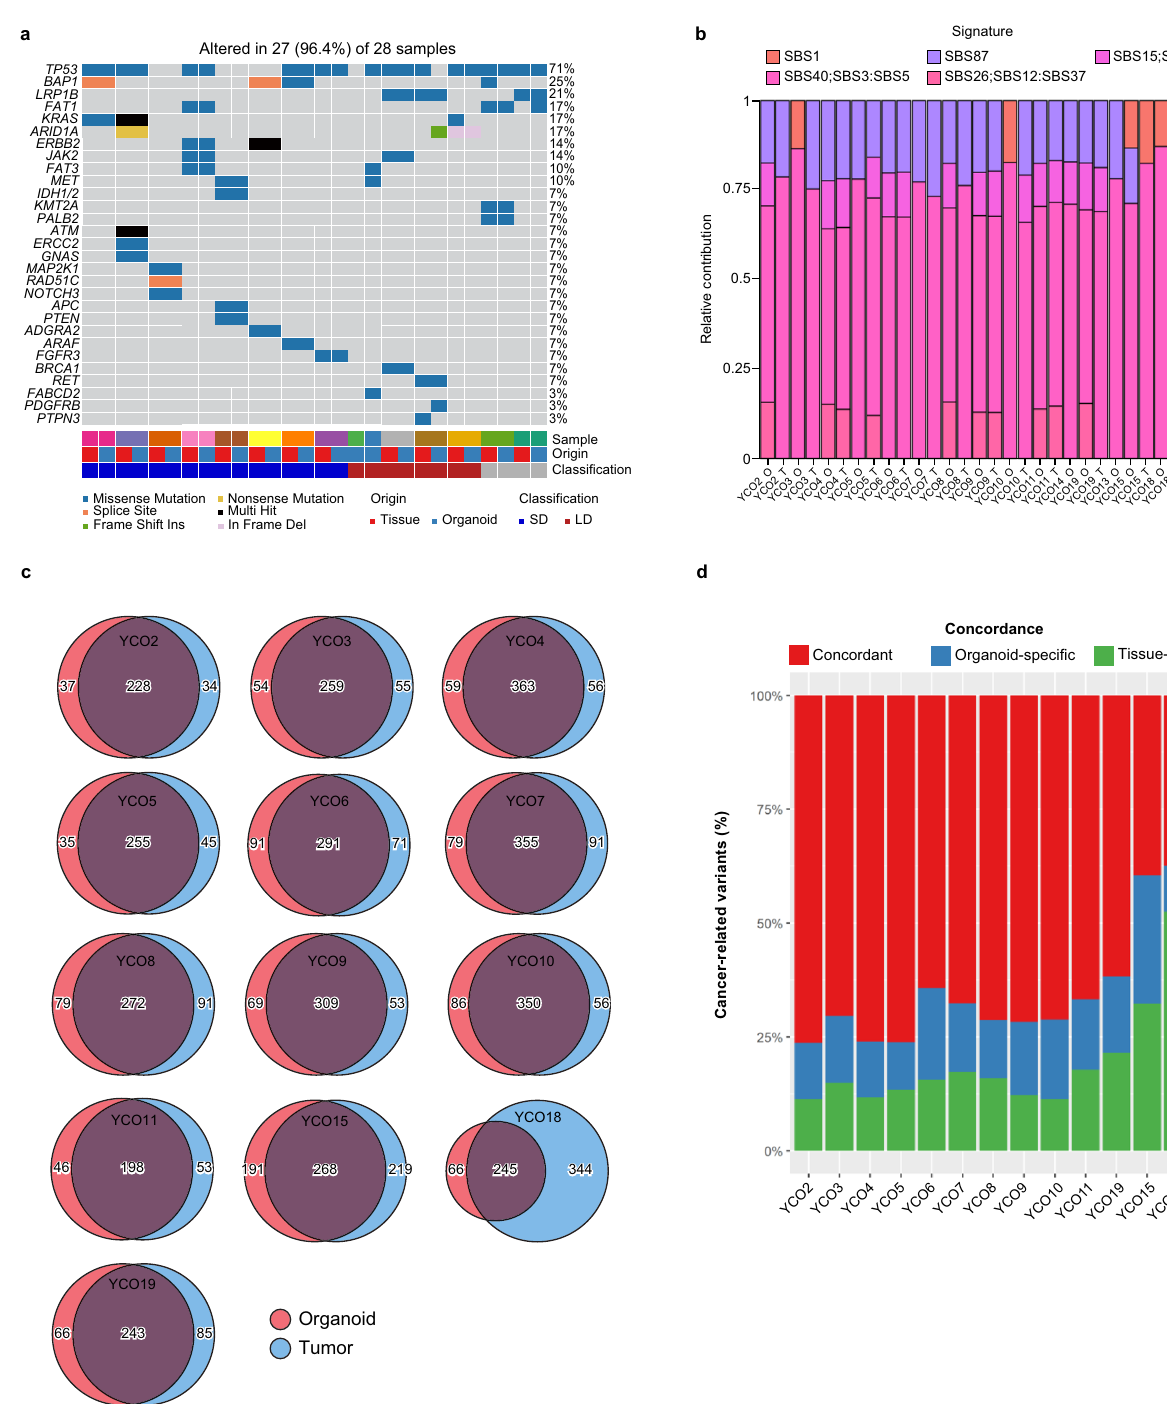
Fig. 3 | Whole exome sequencing. a Heatmap of somatic mutations in cho- langiocarcinoma( n =15). b Genesignaturesaccordingtoeachorganoidandtumor ( n =15). c Somaticmutations shared betweenprimarytumorsand organoids.Venn diagrams show tumor organoid and primary tumor single nucleotide variants